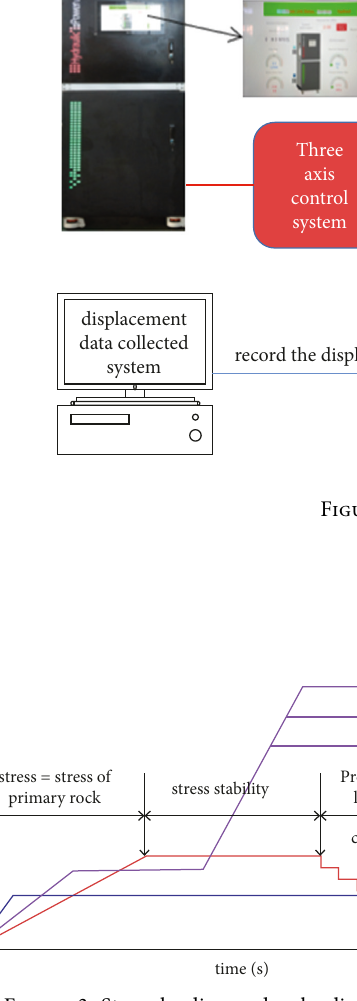
Figure 3: Stress loading and unloading test